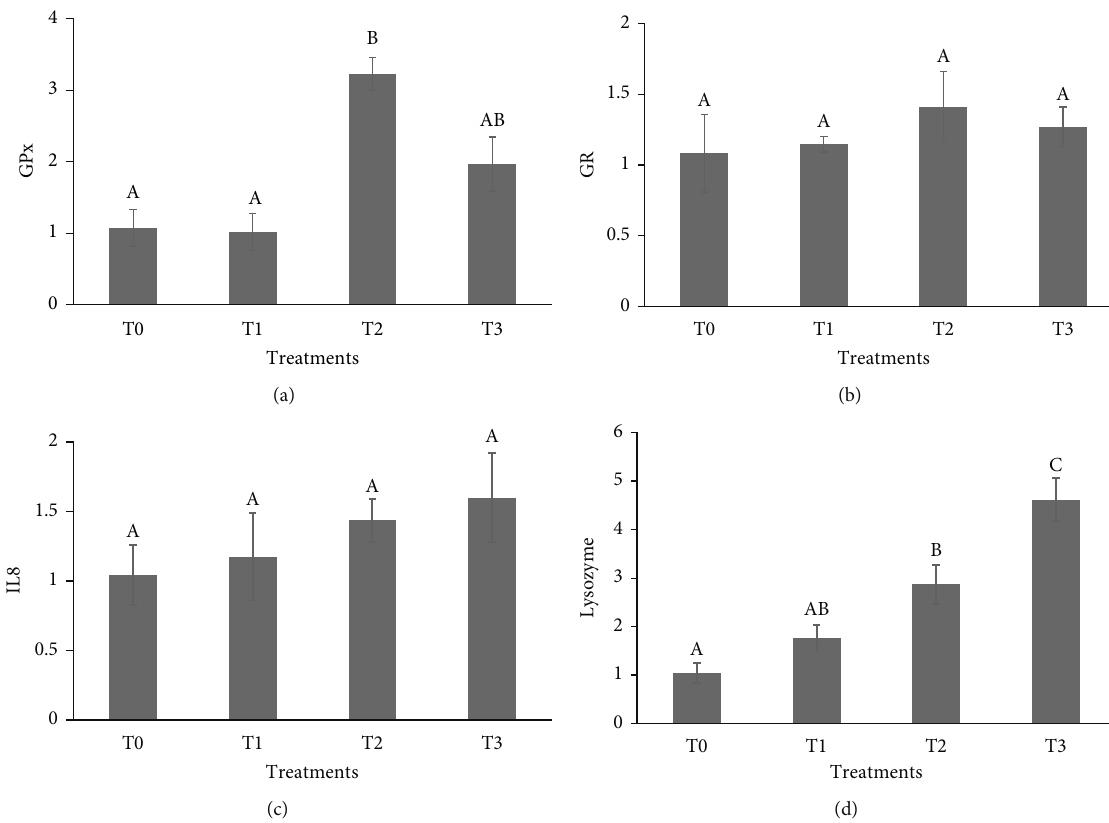
Figure 1: Relative expression of glutathione peroxidase (a, GPx), glutathione reductase (b, GR), interleukin-8 (c, IL8), and lysozyme (d) of common carp ( Cyprinus carpio ) fed with 0 (T0), 200 (T1), 400 (T2), and 600 (T3) mg/kg quercetin for 8 weeks and challenged with heat stress. Di ff erent letters designate signi fi cant di ff erences as determined by Duncan ’ s multiple range test ( mean ± SD